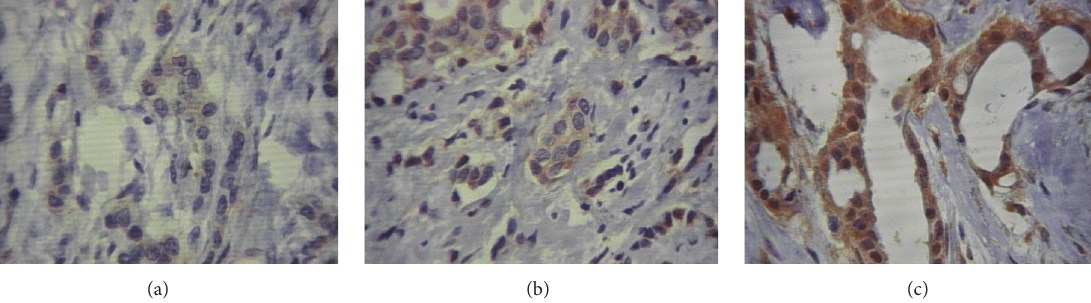
Figure 4: CXCR4 protein expression in breast tumor tissue samples. CXCR4 immunoreactivity was observed in the cytoplasm of tumor epithelial cells. Representative micrograph result for positive CXCR4 staining: (a) weak staining = 1, (b) moderate staining = 2, and (c) strong staining = 3. CXCR4 cytoplasmic expression in invasive breast carcinoma (400x).